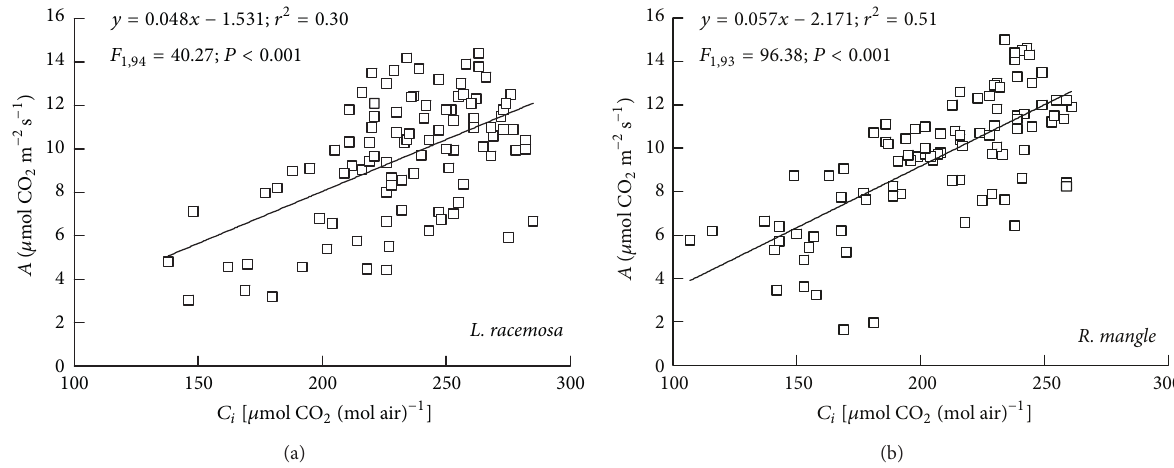
Figure 3: Relationship between intercellular CO 2 concentration ( 𝐶 𝑖 ) and carbon assimilation rate ( 𝐴 ) for (a) Laguncularia racemosa and (b) Rhizophora mangle seedlings grown at different hydroperiods and salinity